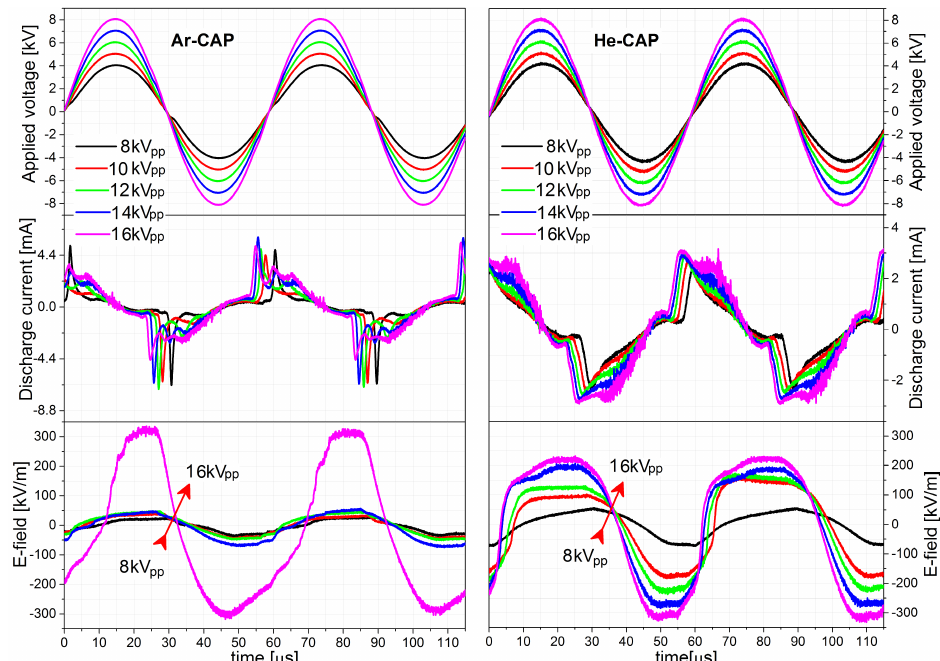
Figure 3. The applied voltage, discharge current and electrical field data for the Ar ( left ) or He ( right ) CAP facing a dielectric surface at a distance d = 10 mm (probe head).